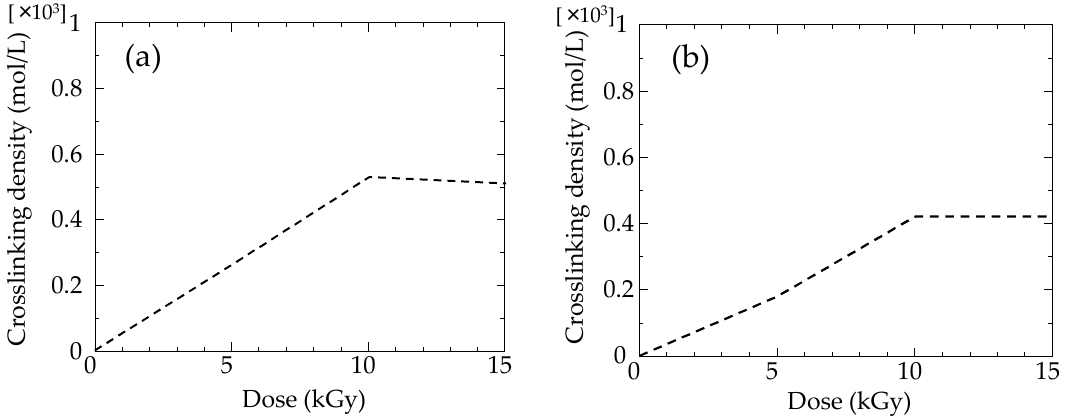
Figure 6. Simulated crosslinking density of ( a ) H5, and ( b ) H9 nanogels as a function of radiation dose.